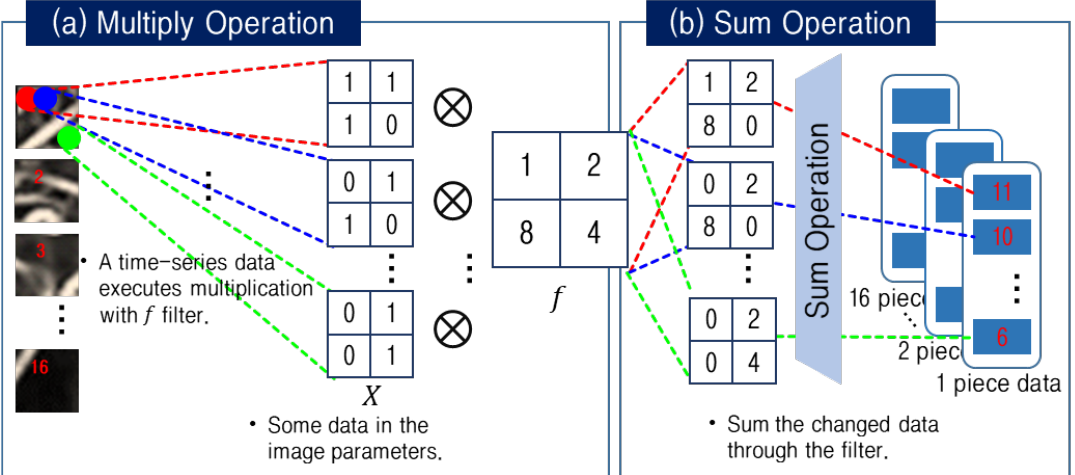
Figure 5. Conversion from a segment image to 1D vector data: ( a ) Multiply operation; ( b ) Sum operation.